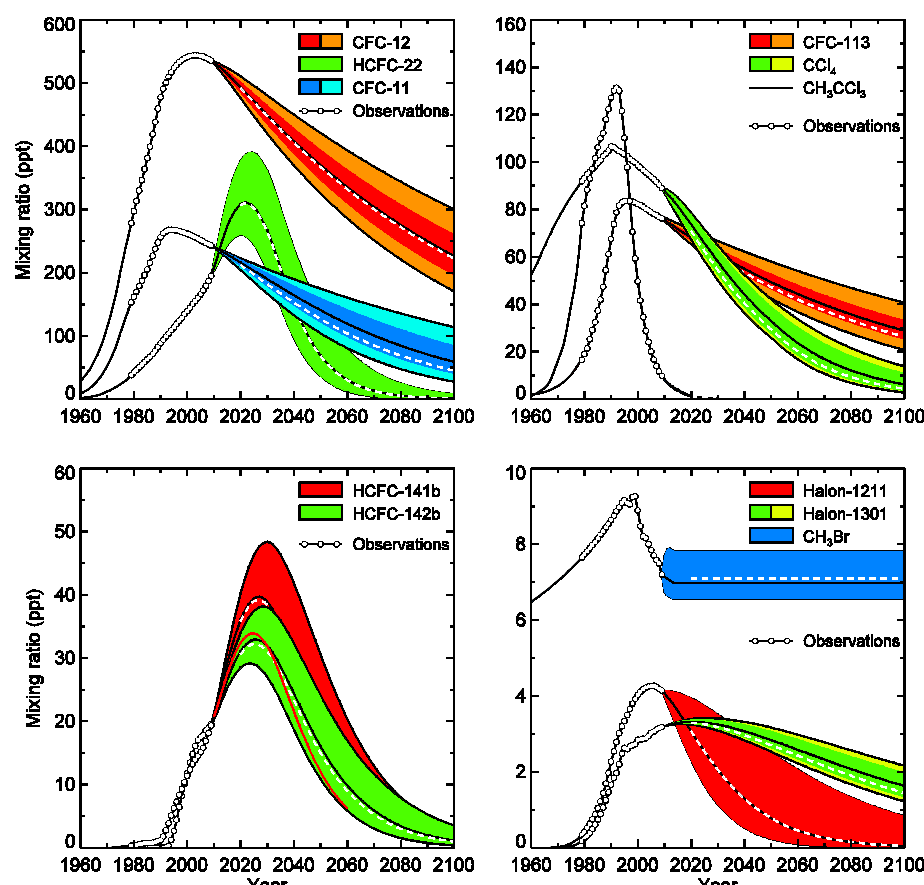
Figure 3 Fig. 3. Mixing ratios of ODSs from 1960 to 2100 based on lifetimes and their uncertainties from SPARC (2013). Shown are the median values and 95% confidence interval based on the most likely (dark colors) and possible (light colors) uncertainty ranges in lifetimes. Open circles show the observed mixing ratios. White dashed lines represent the median values of the mixing ratios based on lifetimes from WMO